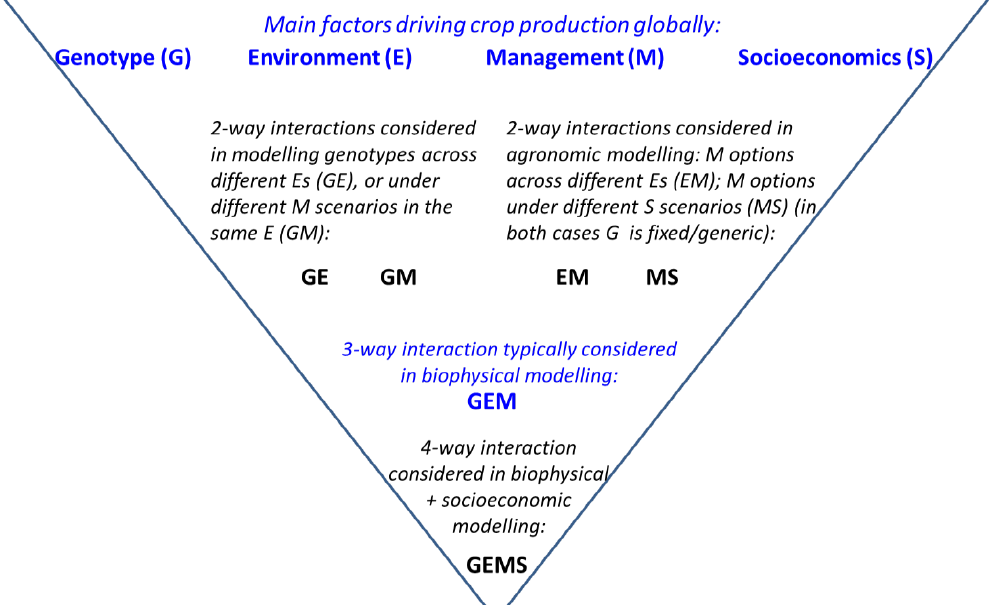
Figure 1. Crop modelling factors and relevant interactions. Four-way modelling captures the complex interactions of genotype, environment, management, and socioeconomics.